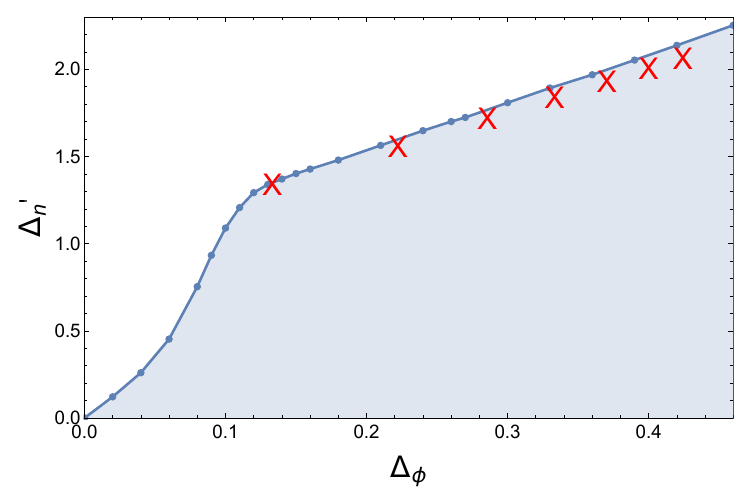
Figure 6 . Numerical bootstrap bound on the scaling dimension of the second n-channel scalar operator in CFTs with S 3 symmetry. The crosses correspond to minimal models with